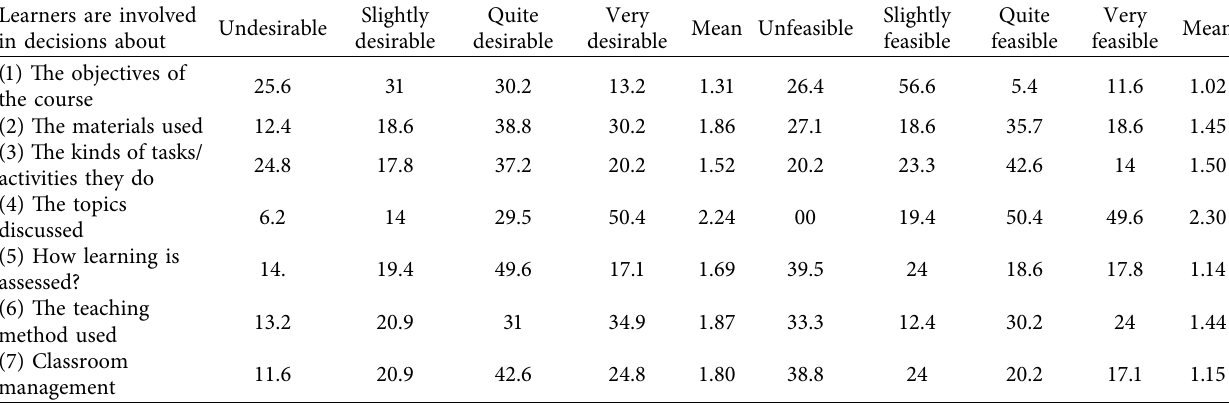
Table 9: Descriptive statistics of the desirability and feasibility of learners’ involvement in decision-making.